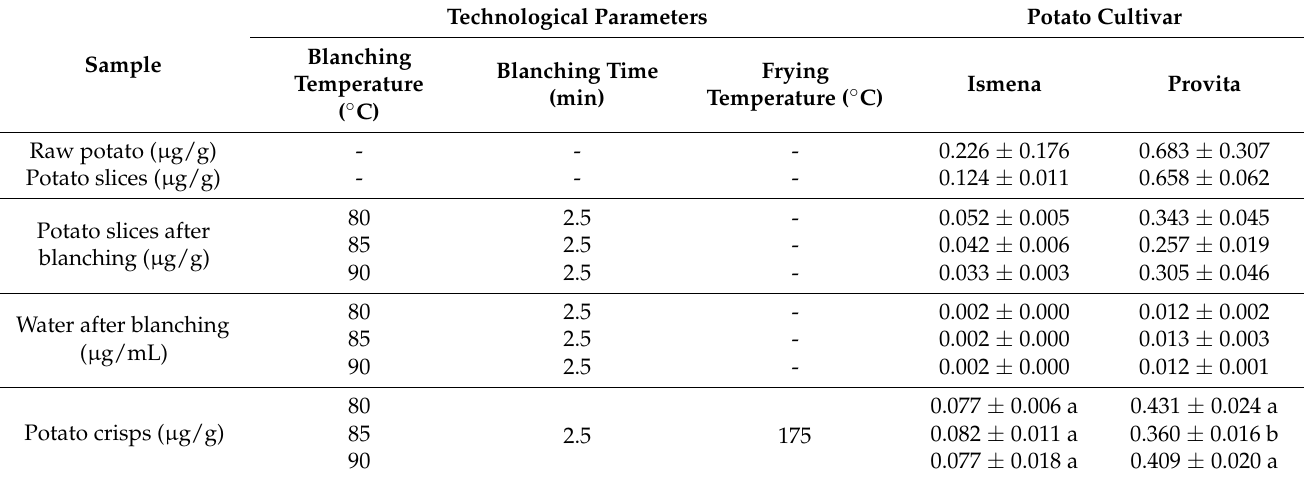
Table 7. Kynurenic acid content changes with potato crisp